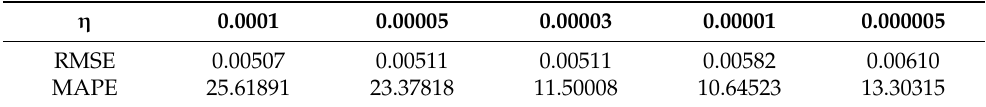
Table 2. The influence of different learning rates on the